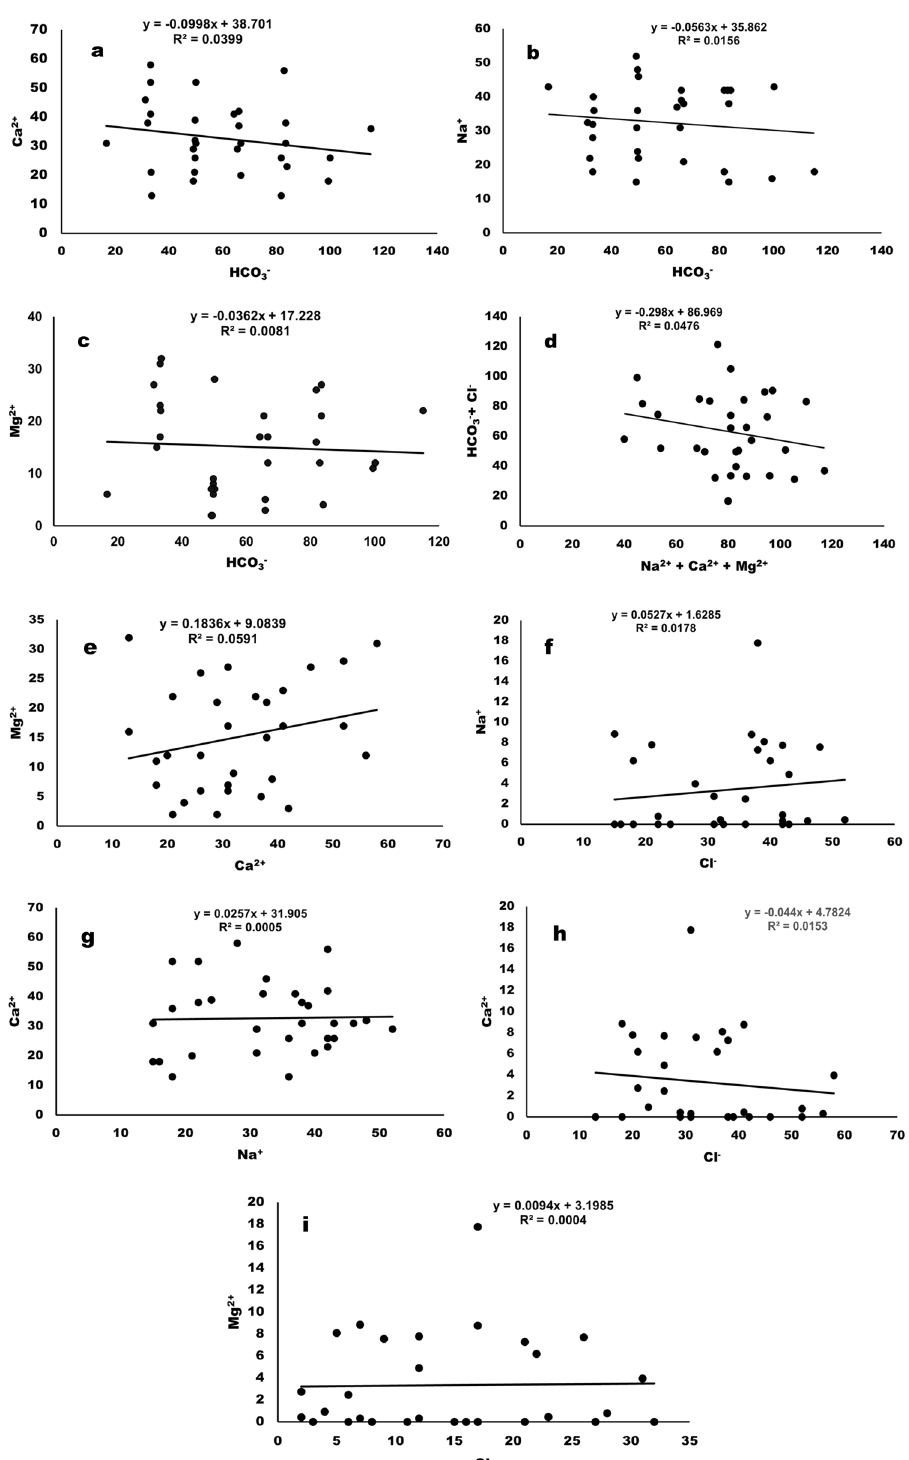
Figure 11. Hydrologic processes, statistical analyses of the correlations between ( a ) Ca 2+ vs HCO 3- ( b ) Na 2+ vs. HCO 3 - ( c ) Mg 2+ vs. HCO 3 - ( d ) HCO 3 - + Cl - vs. Na + + Mg 2+ + Ca 2+ ( e ) Mg 2+ vs. Ca 2+ ( f ) Na 2+ vs. Cl - ( g ) Ca 2+ vs. Na 2+ ( h ) Ca 2+ vs. Cl - & ( i ) Ma 2+ vs. Cl -